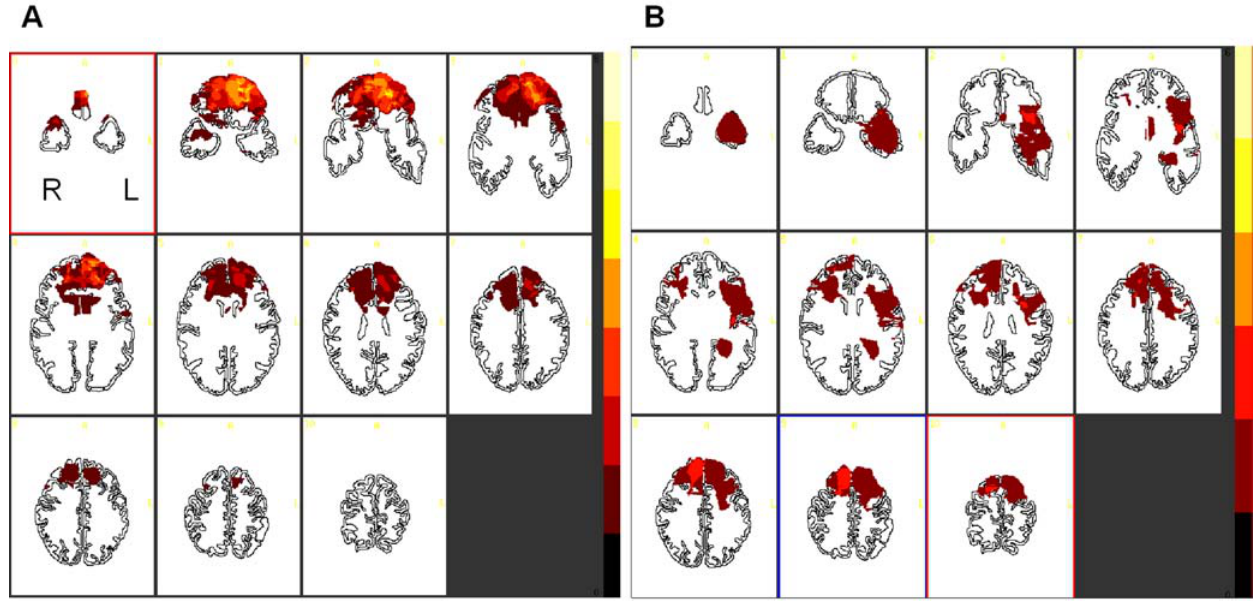
Figure 1. (A). Location and degree of lesion overlap in patients with fronto-polar cortex lesions. (B). Location and degree of lesion overlap in control patients without fronto-polar cortex lesions. Slices are oriented in radiological convention (i.e. the left side of the image is the right hemisphere). Lighter colors denote the degree to which lesions involve the same structure in multiple subjects. The darker color at the bottom of the color scale indicates no overlap between brain